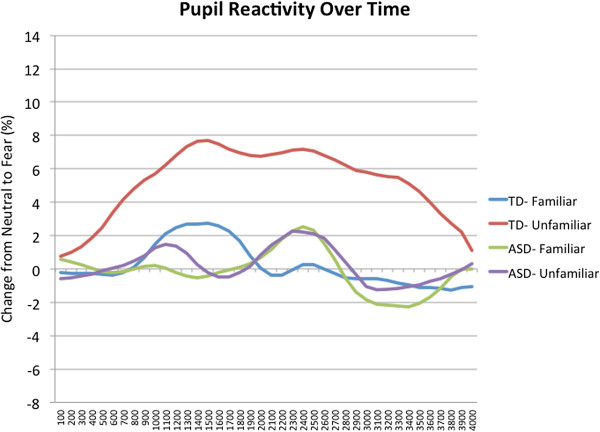
Change in pupil diameter from neutral expression to fear expression over time (shown as a percentage). Unadjusted means, in increments of 100 ms and smoothed with a seven-point moving average filter, for each familiarity condition and group.